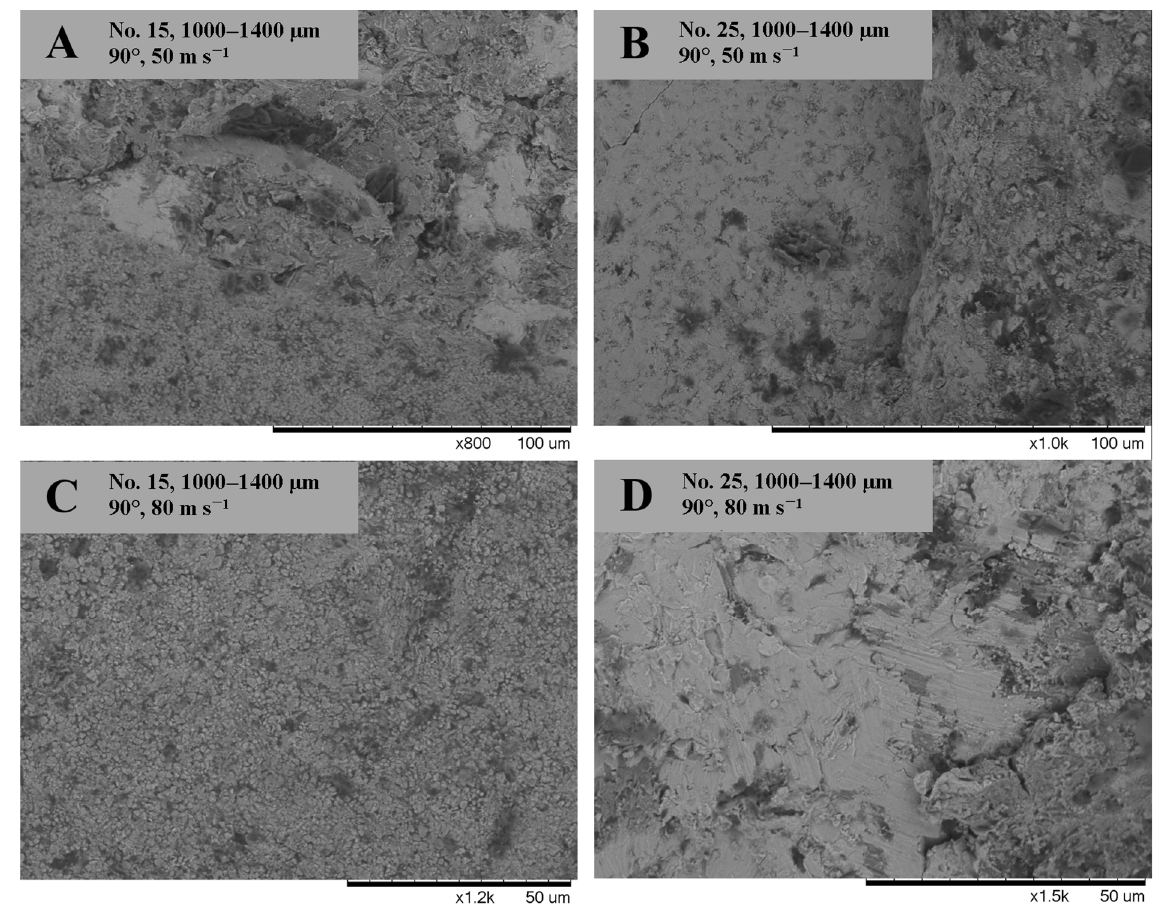
Figure 9. SEM images of the sample surfaces after erosive test at 50 ( A , B ) and 80 ( C , D ) m · s − 1 particle velocity and 90° impact.